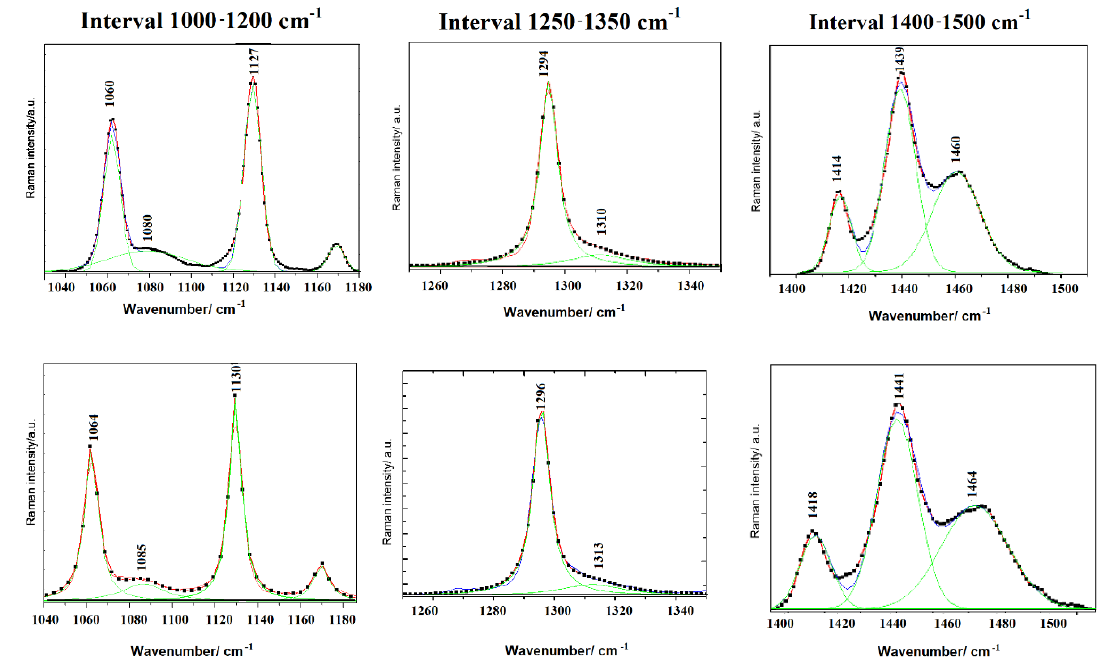
Figure 6. Computational spectral deconvolution and curve fitting procedure of the main wavenumber intervals in Raman spectra and identification of relevant sub-bands: new UHMWPE component ( upper panels ) and retrieved component ( lower panels ).